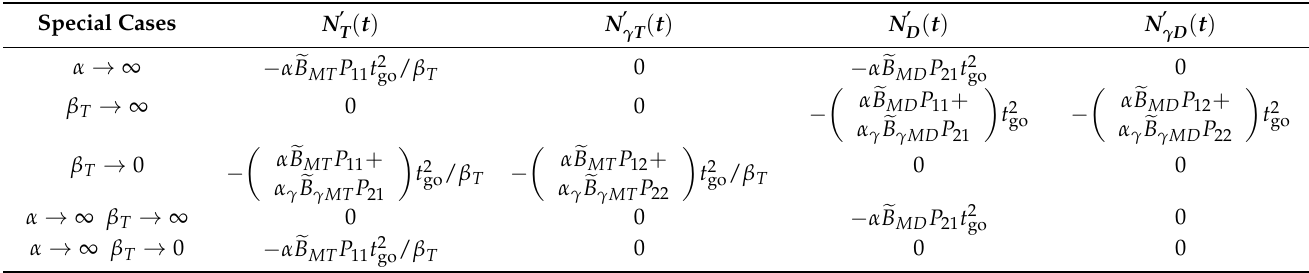
Table 1. Navigation gains of special cases for a two-way